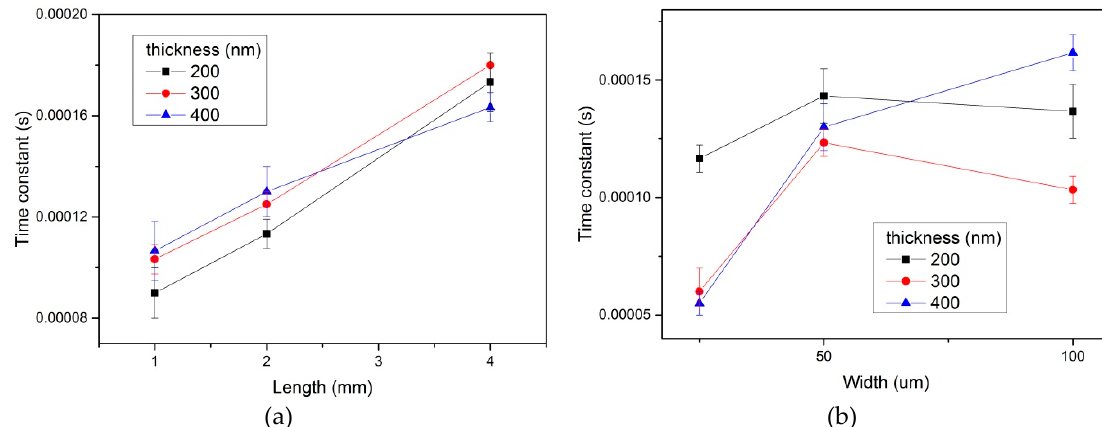
Figure 6. Time constant of the three groups (di ff erent thickness) of the flexible hot film shear stress sensor with di ff erent length ( a ) and width ( b ). Estimated accuracy for time constant is ± 5 percent, for length and width, ± 1 percent.